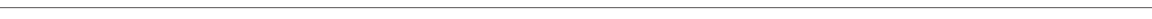
Frontiers in Physics |